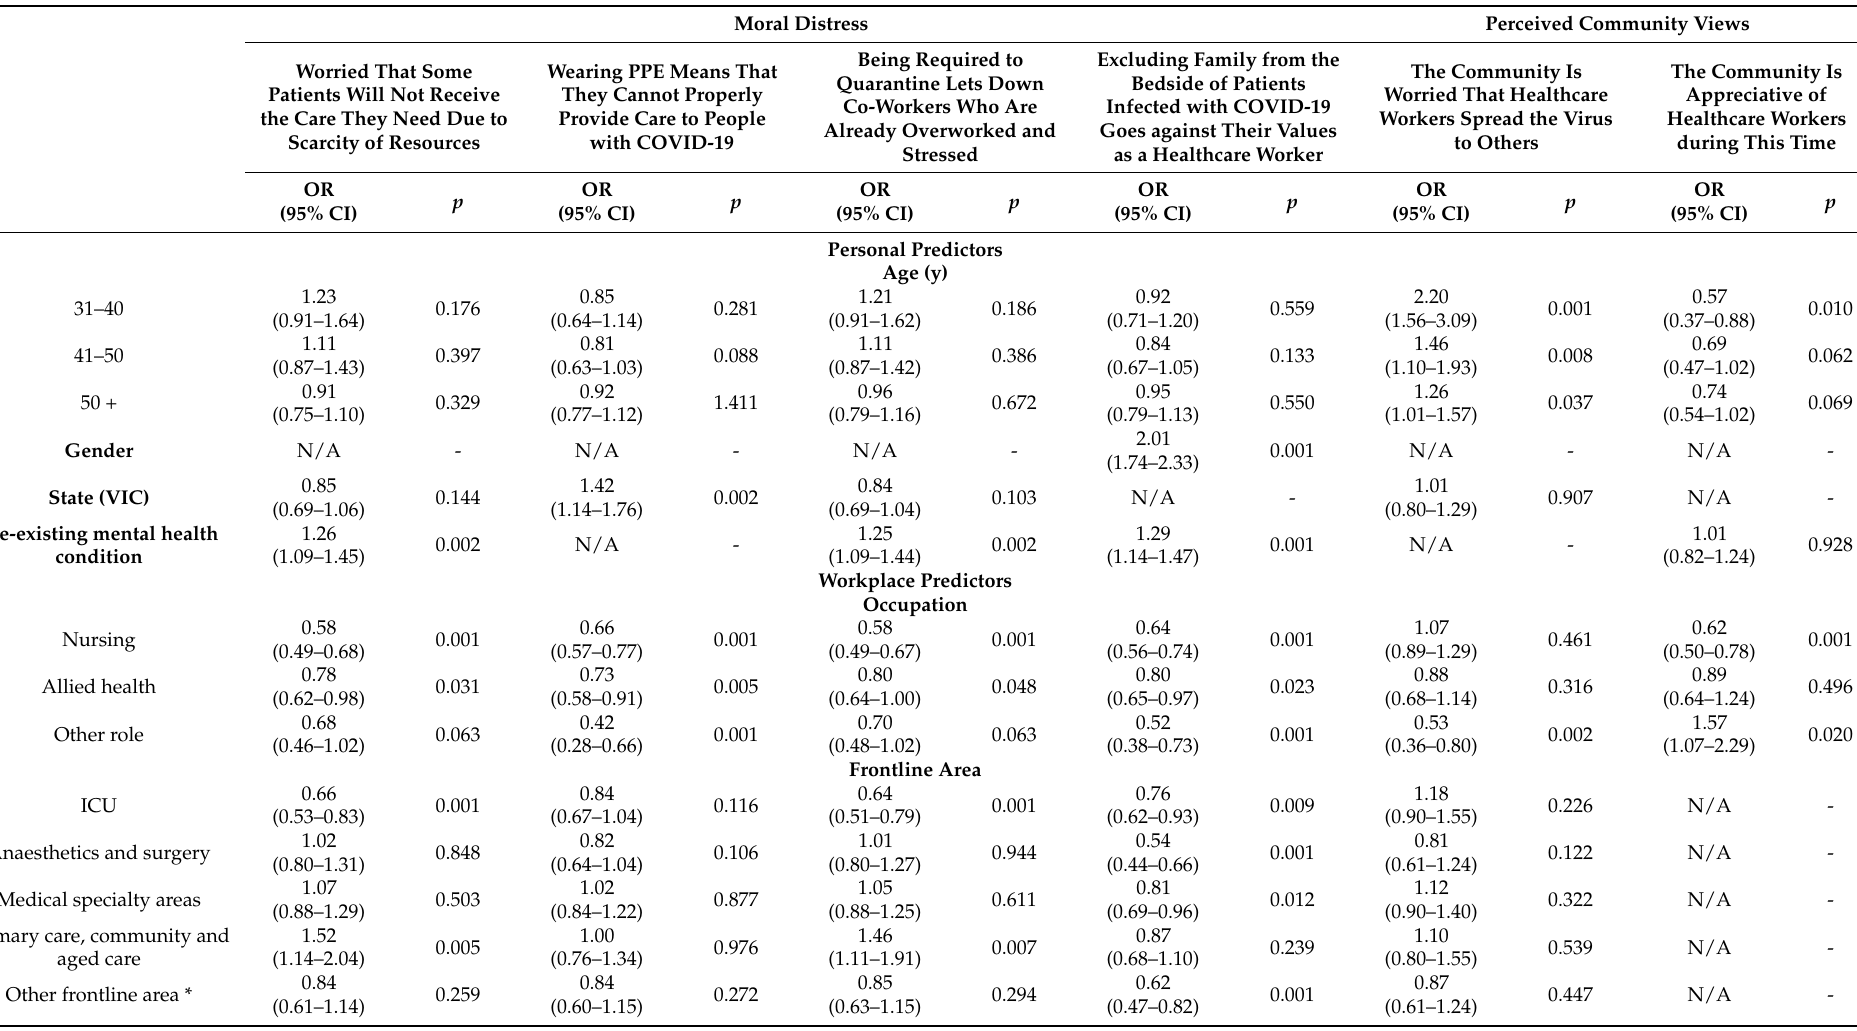
Table 3. Personal and workplace predictors of moral distress and perceived community view (multivariate